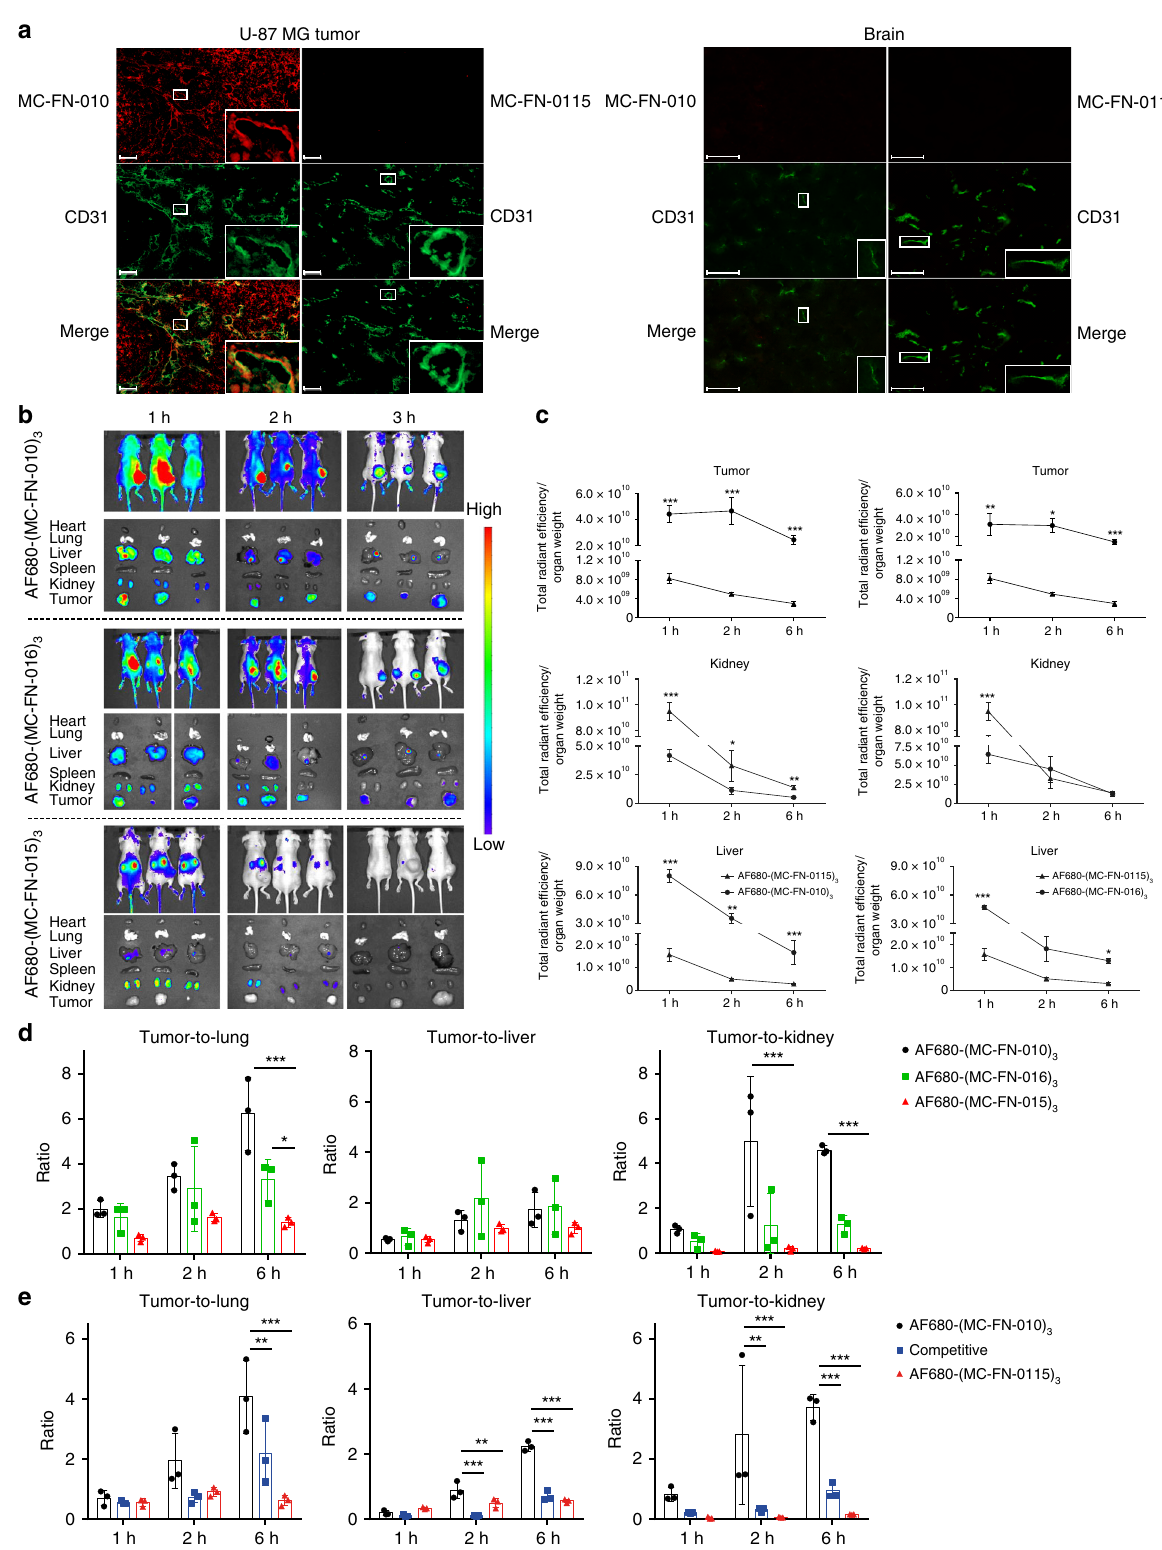
speci fi city of its binding to EDB for further development. Mapping of the MC-FN-010-binding site through alanine scanning mutagenesis revealed that the amino acid residues R- I-R-L in the fi rst loop and an arginine residue in the fi fth loop are required for EDB-binding activity of the peptide. One may speculate that the consensus sequence together with amino